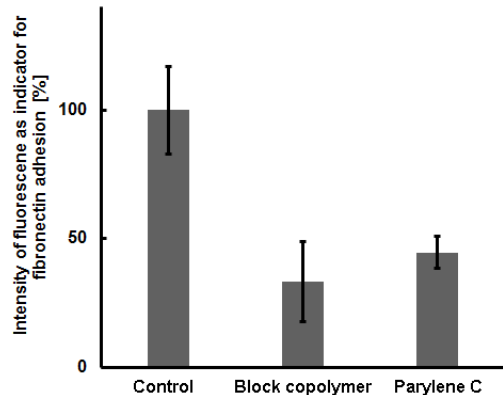
Figure 10. Intensity of fluorescence as an indicator for fibronectin adhesion after incubation with labeled fibronectin HiLyte 488 ( n = 5).